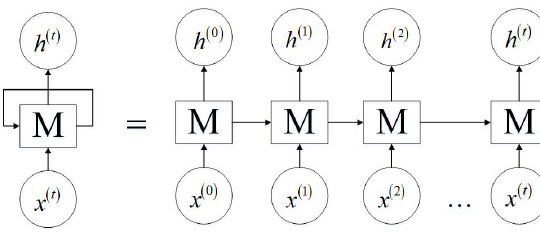
Figure 1. Recurrent neural network (RNN) expansion structure.